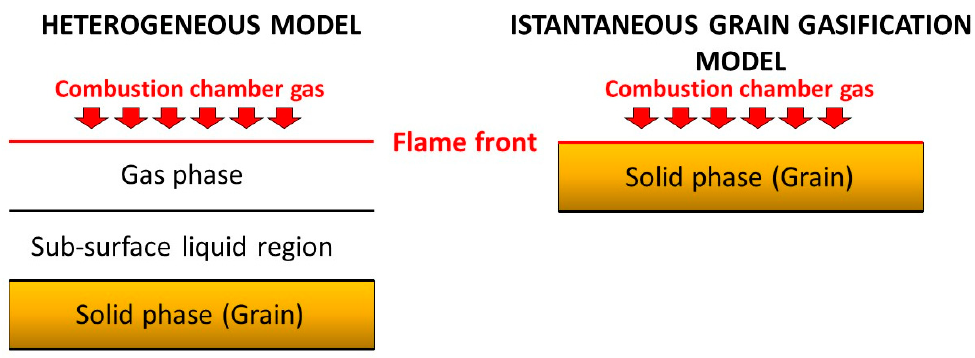
Figure 8. Grain combustion models.